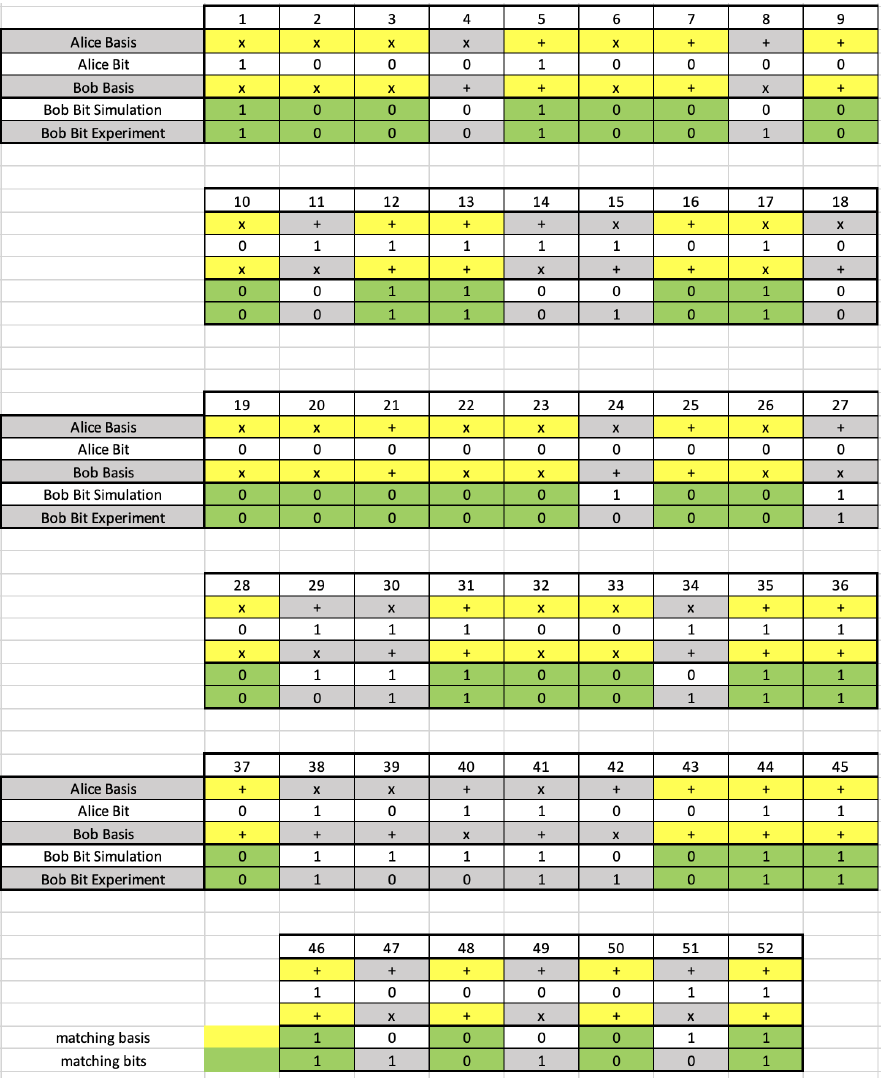
Figure A2. 52 bit key distribution results—Alice &